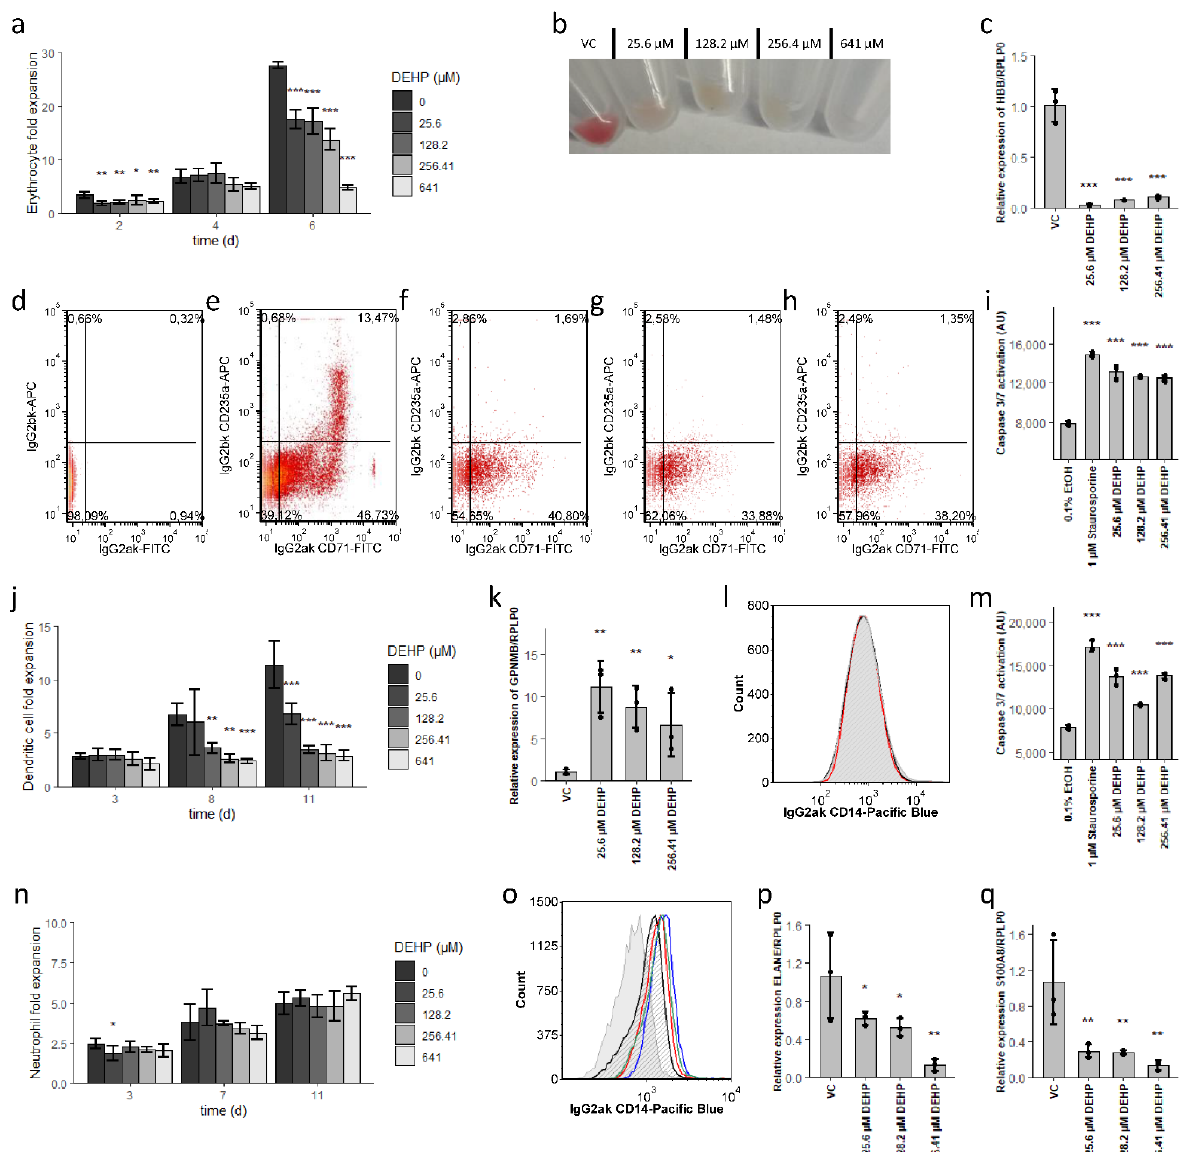
Figure 1. Differential disruption of myeloid lineage differentiation by DEHP. ( a , j , n ) Expansion of erythrocyte ( a ), dendritic cell ( i ), and neutrophil ( n ) cultures in the presence of increasing concentrations of DEHP. ( b ) Cell pellet representing erythroid populations after 6 days of treatment with increasing concentrations of DEHP. ( c ) Impact of increasing concentrations of DEHP on the relative expression of HBB in differentiating erythrocytes after 6 days. ( d – h ) Expression of CD71 and CD235a in erythroid populations after 6 days of treatment with varying concentrations DEHP. From left to right: isotype control ( d ), vehicle control ( e ), 25.6 µM ( f ), 128.2 µM ( g ), and 256.41 µM DEHP ( h ). ( i , m ) Caspase activity in differentiated erythroid populations after 2 days ( i ) and in dendritic cell populations after 3 days ( m ) of treatment with varying concentrations of DEHP. Cells treated with staurosporine were included as positive controls. ( k ) Impact of DEHP on the relative expression of GPNMB in dendritic cell cultures. ( l ) Expression of CD14 on dendritic cells treated with 256.41 µ M DEHP (red) compared to vehicle control (black); isotype control is as shown (grey-filled). ( o ) Expression of CD14 on neutrophils treated with 25.6 µ M (red), 128.2 µ M (green), and 256.41 µ M DEHP (blue) compared to vehicle control (black); isotype control is as shown (grey). ( p , q ) Impact of DEHP on the relative expression of ELANE ( p ) and S100A8 ( q ) in neutrophils. Data are presented as mean ± standard error of the mean (SEM); individual replicates are visualized as black dots in bar charts in case of n = 3. Significance was determined by one-way ANOVA (* p < 0.05; ** p < 0.01; *** p <